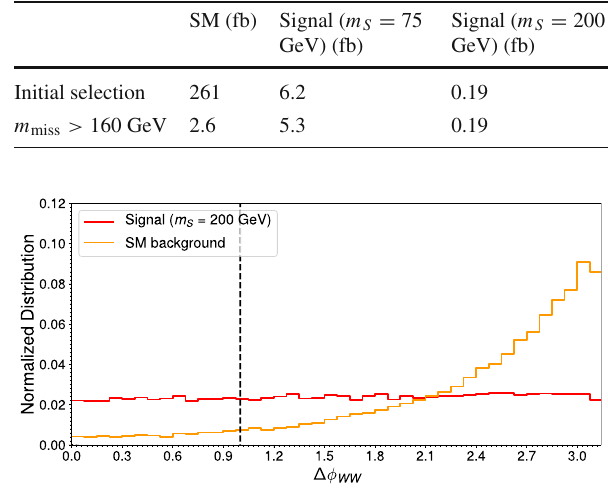
simple cutflow are shown in Table 1. The corresponding 2 σ √ B = 2 (with S and B the respective exclusion sensitivity S / number of signal and background events) for λ HS as function of m S is shown in Fig.